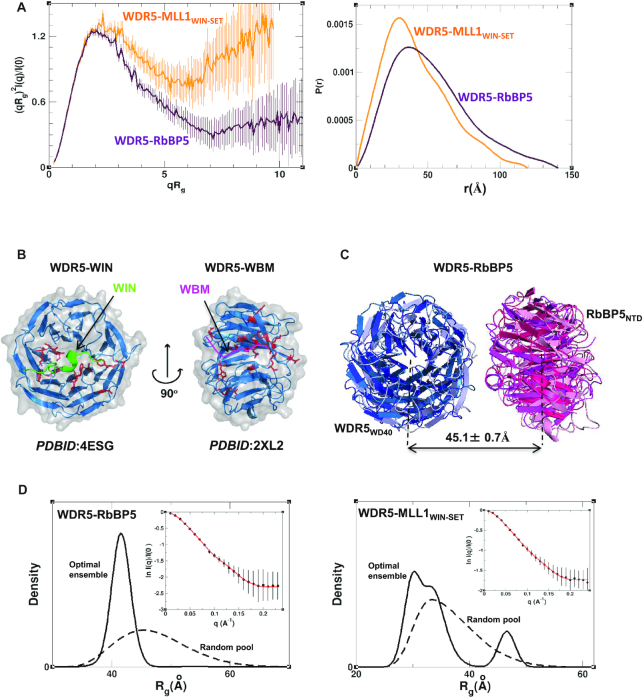
WDR5–MLL1 and WDR5–RbBP5 binary complexes. (A) Rg-based Kratky plots (left) of SAXS data for binary complexes of WDR5–MLL1WIN-SET (orange) and WDR5–RbBP5 (maroon). Normalized pair distance distribution functions P(r) calculated from experimental SAXS data with GNOM (right). The data indicate that while both complexes are flexible, WDR5–MLL1WIN-SET possesses a significantly higher degree of flexibility than WDR5–RbBP5. (B) WDR5 residues (red, in stick representation) that exhibit the highest CSPs in (1H-15N)-TROSY titrations with peptides corresponding to the WIN (green) and WBM motifs (pink) (CSPs > 0.15 ppm for WIN peptide, CSPs > 0.23 for WBM peptide). CSPs are mapped onto the crystal structures of WDR5–WIN peptide (PDB ID: 4ESG) and WDR5–WBM peptide (PDB ID: 2XL2). Histograms presenting complete CSP data obtained from the two titrations are presented in Supplementary Figure S5A. (C) The centers of geometry of RbBP5NTD (pink) and WDR5WD40 (blue) domains are positioned at about the same distance (∼45 Å) in 95% of the models in the optimal ensemble. (D) Rg distribution for the initial pool of random structures (dashed) and for the SAXS-derived optimal ensemble (solid) of WDR5–RbBP5 (left) and WDR5–MLL1WIN-SET (right). Experimental SAXS profiles (black circles) with theoretical profiles (red line) averaged over the SES ensemble (inset).